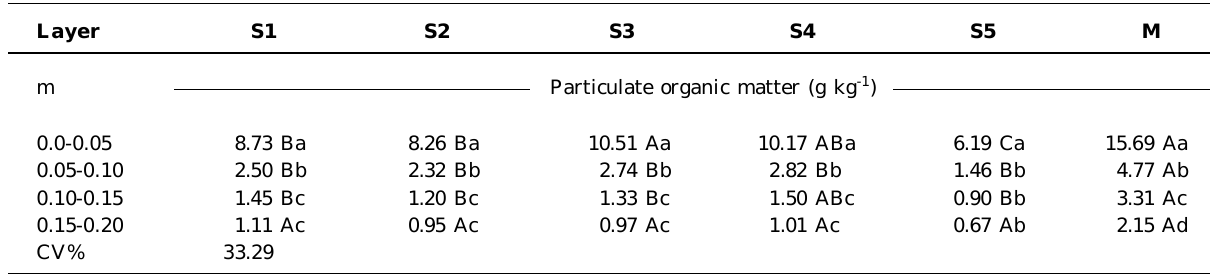
Table 4. Mean values of particulate organic matter (g kg -1 ) in four soil layers of different crop rotations and integrated crop-livestock systems